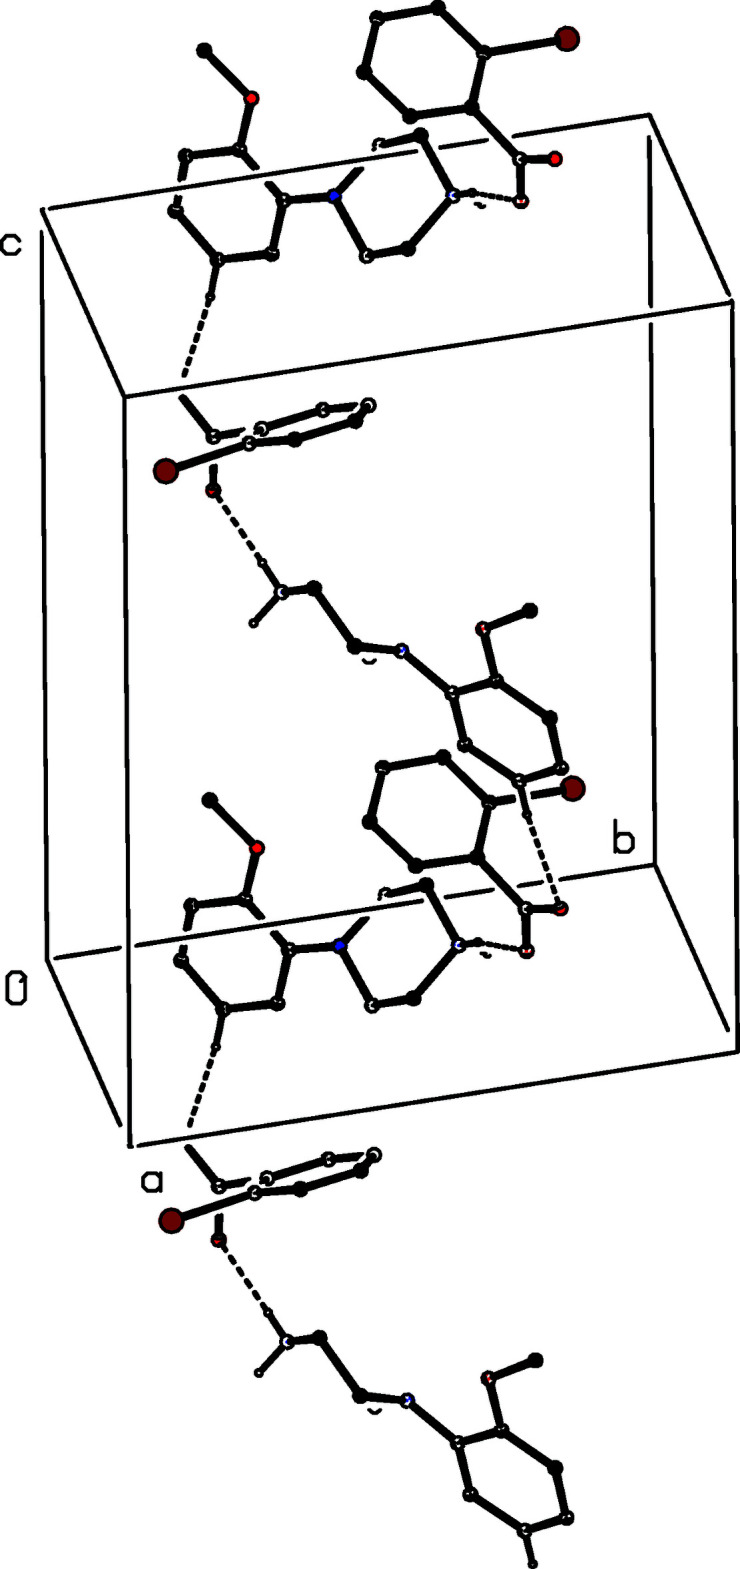
Part of the crystal structure of compound (VI) showing the formation of a (12) chain running parallel to [001], in which ion pairs are linked by a C—H⋯O hydrogen bond. Hydrogen bonds are drawn as dashed lines and, for the sake of clarity, the H atoms not involved in the motif shown have been omitted.